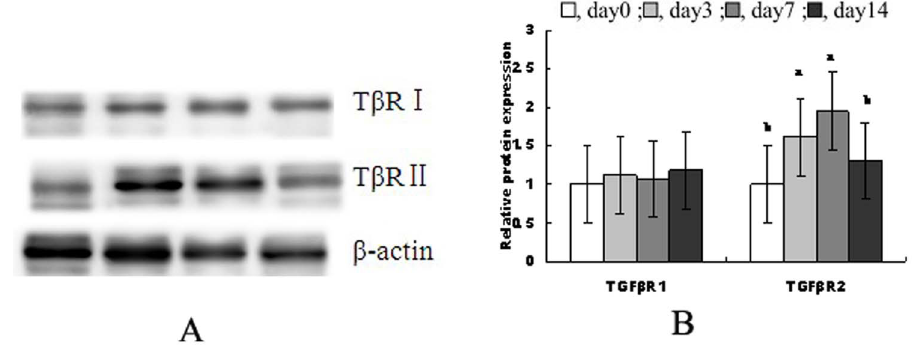
Figure 3. The protein levels of T b RI and T b RII in jejunal mucosa during the 2 weeks after weaning. (A) shows representative blots of T b R I, T b R II proteins expression and b -actin on 0, 3, 7 and 14 post-weaning, respectively. (B) shows relative T b R I and T b R II proteins expression. a,b, Mean values with unlike letters were significantly different ( P , 0.05). Values are means and standard deviations represented by vertical bars. The value of protein expression was the ratio of the densitometry units of T b R I, T b R II protein and b -actin. The control sample on day 0 post-weaning was used as the reference sample. The protein expression of all samples was expressed as fold changes, calculated relative to the control group on day 0 post- weaning.